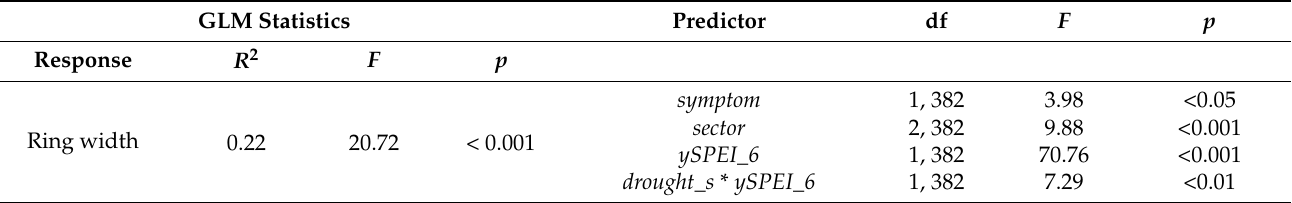
Table 4. Generalized linear model (GLM) for the absolute ring widths in the period from 2010–2018. GLM